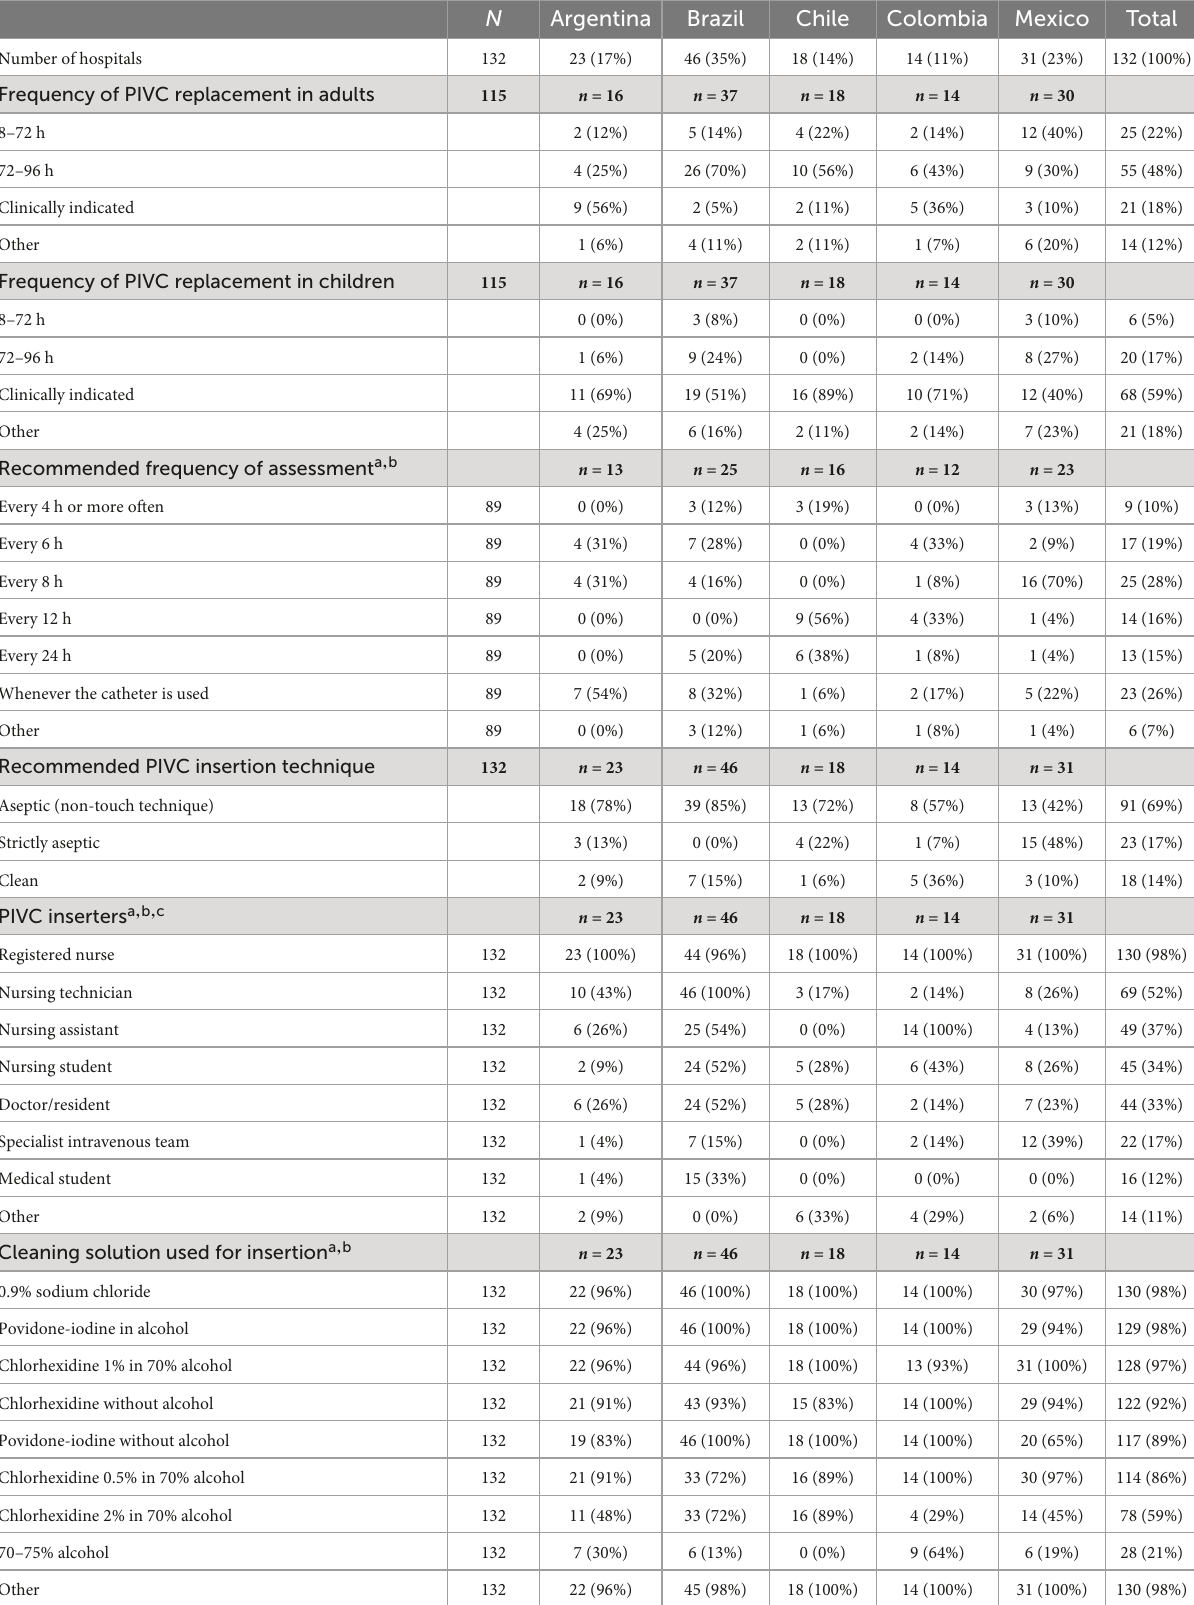
TABLE 1 Characteristics of current practice and guideline recommendations (site information